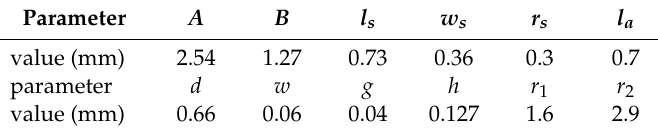
Figure 2. The configuration of the E plane probe. Table 1. Geometrical parameters of the transformer.